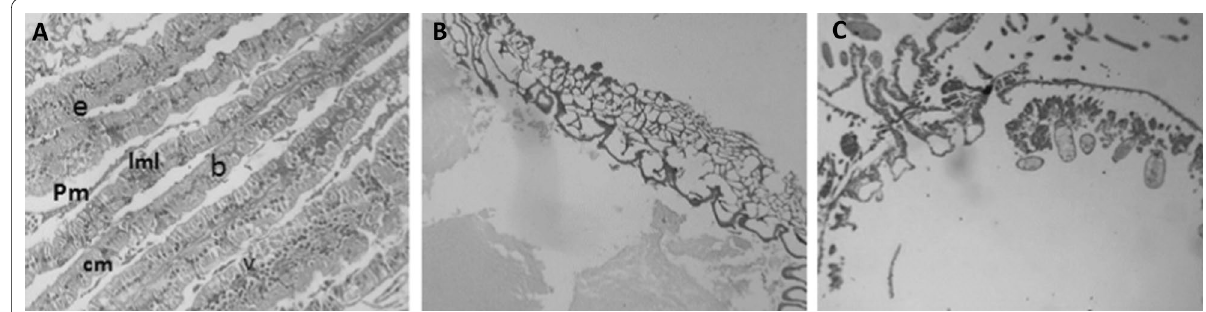
Fig. 6 Midgut region of untreated 5 th nymph instar of Locusta migratoria migratorioides ( A ), Exposure to Photorhabdu luminescens (EGAP3) ( B ), and exposure to cell- free filtrate ( C ) (X 200). lml epithelium and Pm: preitrophic membrane